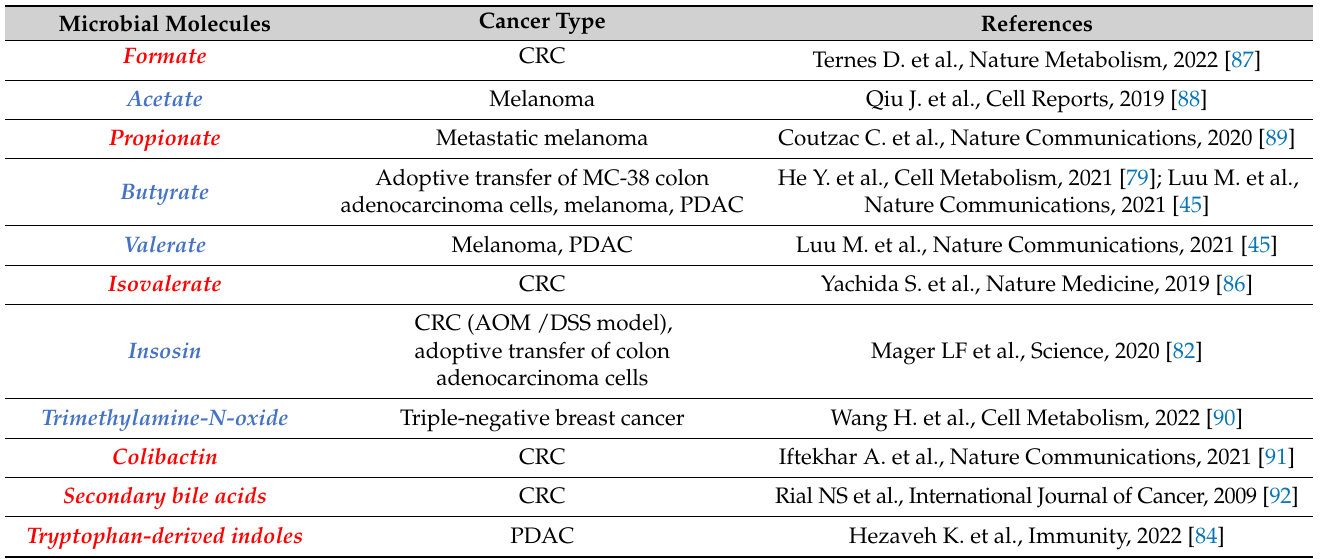
Table 1. Overview of current cancer-specific studies that suggest either promotion of tumor progres- sion or suppression of tumor growth by microbial metabolites. Abbreviations: pancreatic ductal adenocarcinoma (PDAC); colorectal cancer (CRC); azoxymethane (AOM); dextran sodium sulfate (DSS). Red color indicates tumor-promoting role, while blue color is used for tumor-suppressing capacity of